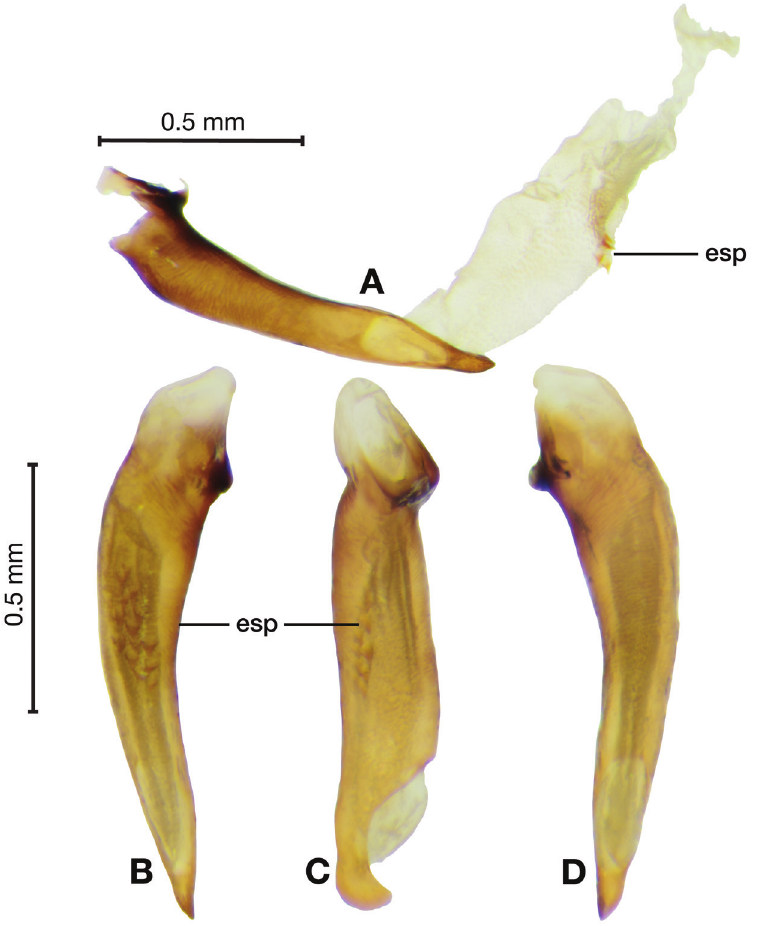
Figure 62. Digital images of male genitalia of Dolichoctis badiadorsis sp. n. . A left lateral aspect, endophal- lus everted B right lateral aspect C ventral aspect D left lateral aspect. Legend: esp endophallic spine